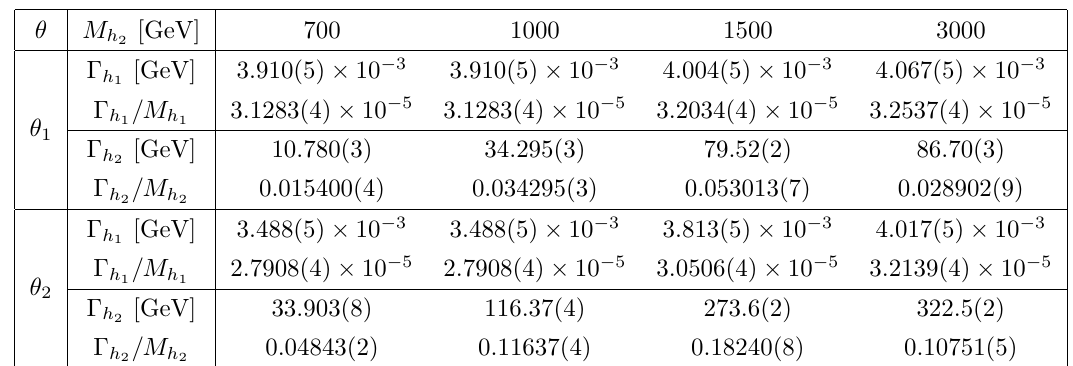
h 1 and 2 in the 1-Higgs-